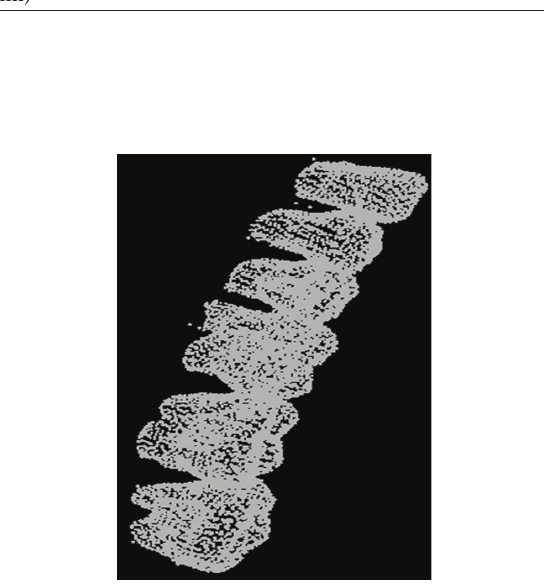
Figure 9: The result of ICP precise registration.